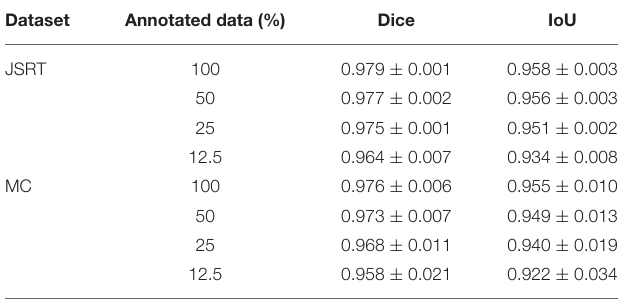
TABLE 4 | Comparison of segmentation results among different unsupervised domain adaptation (UDA)